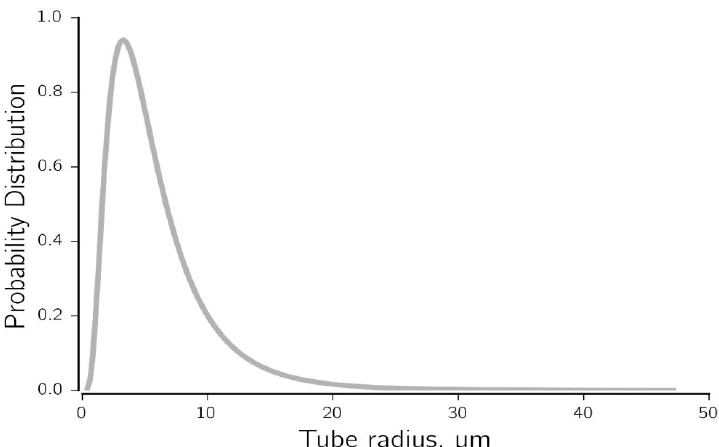
Figure 4 . Distribution of capillary tube radii used in the attempt to reconstruct the characteristics of sandstone core.